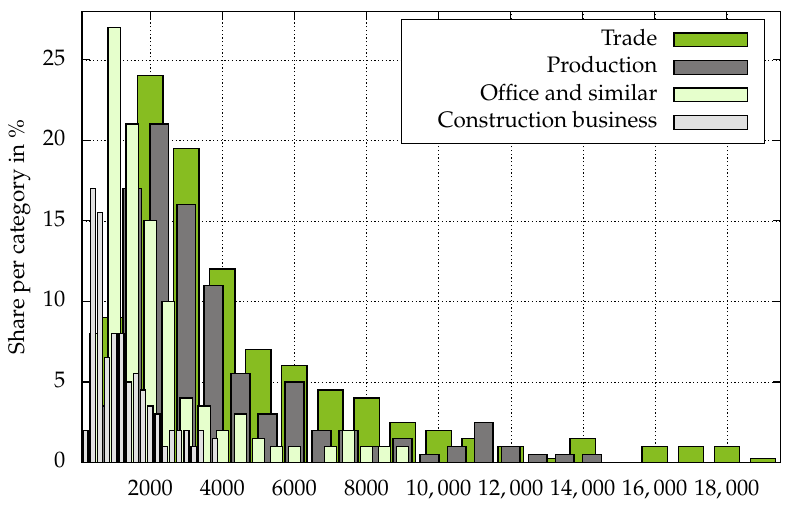
Figure A2. Frequency distribution of the specific electricity consumption by business category (Authors own compilation based on [28]).